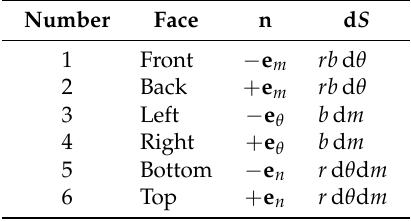
Table A1. Normal vectors and surface elements of the differential control